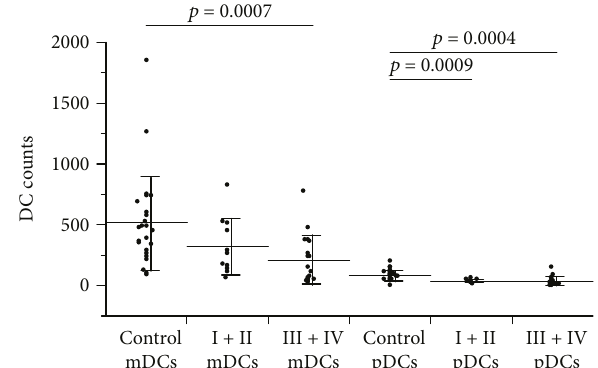
Table 1: Patient characteristics.